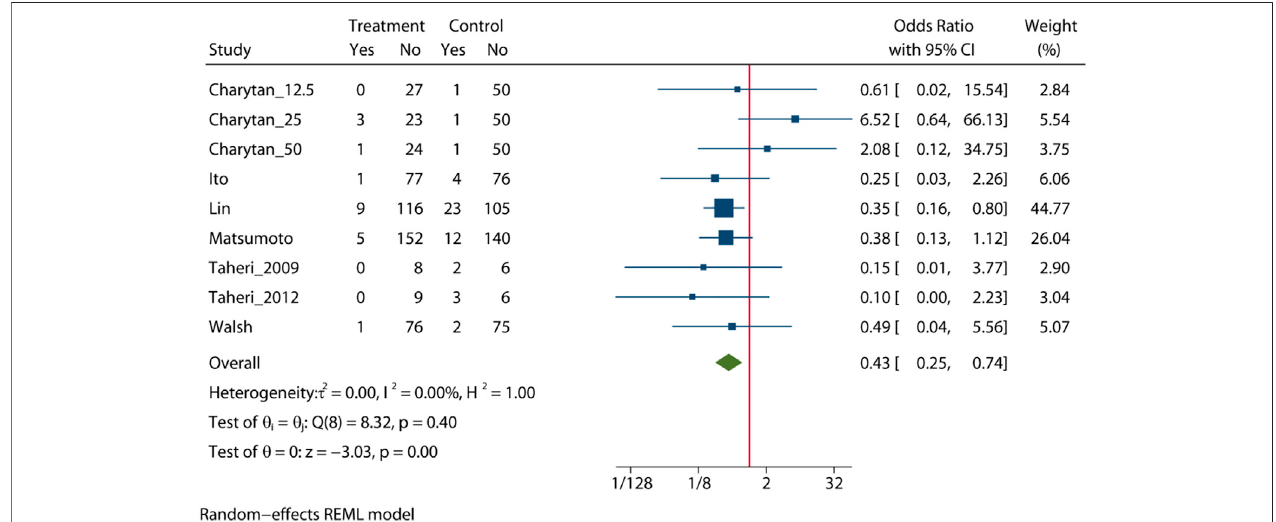
FIGURE 4 | Forest plot of cardiovascular mortality.